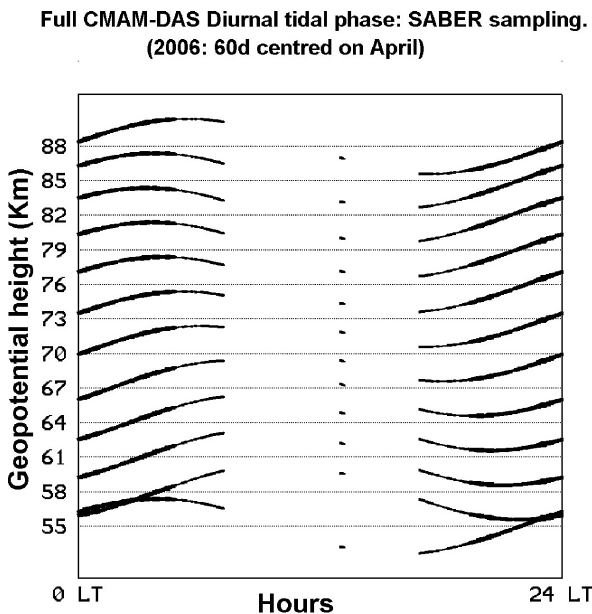
Fig. 5. Sine waves with phase equal to full CMAM-DAS analysis at each height for 50.1 ◦ N are plotted with a thickness proportional the number of SABER samples in the 60d interval to show the weight- ing inherent in the least squares